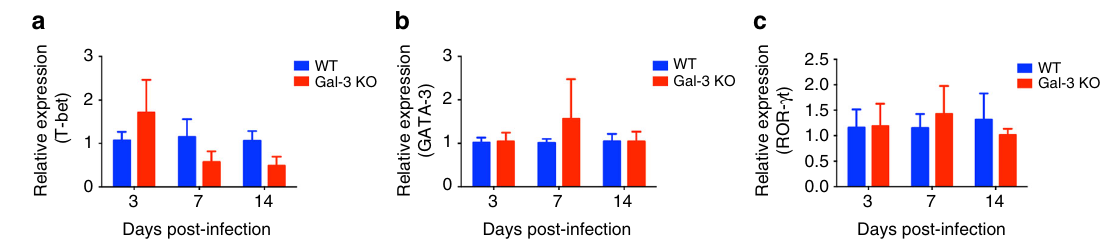
Fig. 5 Levels of T-bet, GATA-3, and ROR- γ t in the lungs of C . neoformans -infected WT and Gal-3 KO mice. WT (blue bars) and Gal-3 KO (red bars) mice were intratracheally infected with H99 yeast cells and samples of their lungs weighed and homogeneized. The levels of mRNA relative expression for T-bet ( a ), GATA-3 ( b ), and ROR- γ t ( c ) in the lungs (3, 7, and 14 days post-infection) of infected mice were determined by real-time PCR, using the β -actin gene as control. The results represent the mean ± SD of fi ve mice per group, from a representative experiment of three